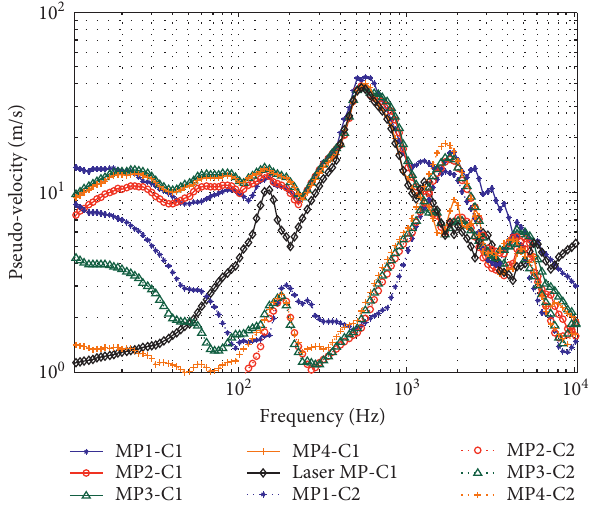
Figure 19: Pseudovelocity shock response spectrums on C1 and C2 under higher SRS.